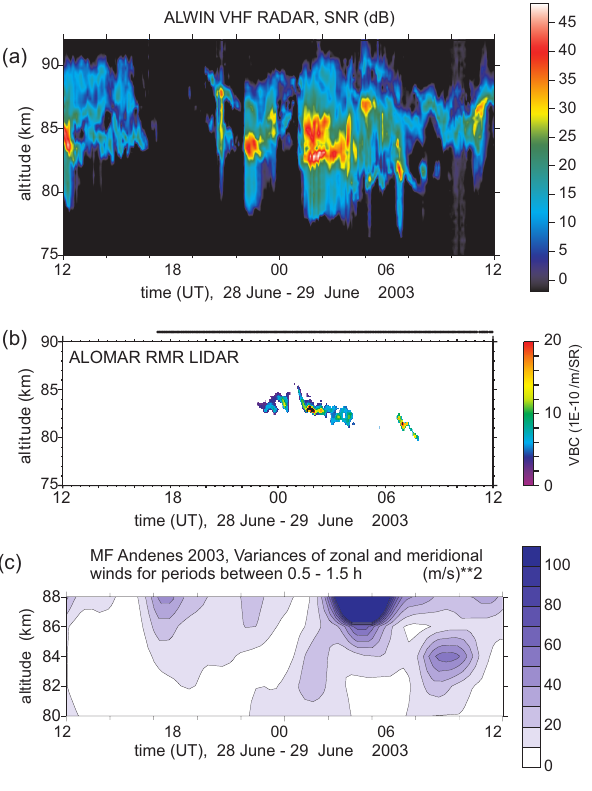
MFAndenes 2003, Variances of zonal and meridional winds for periods between 0.5 - 1.5 h